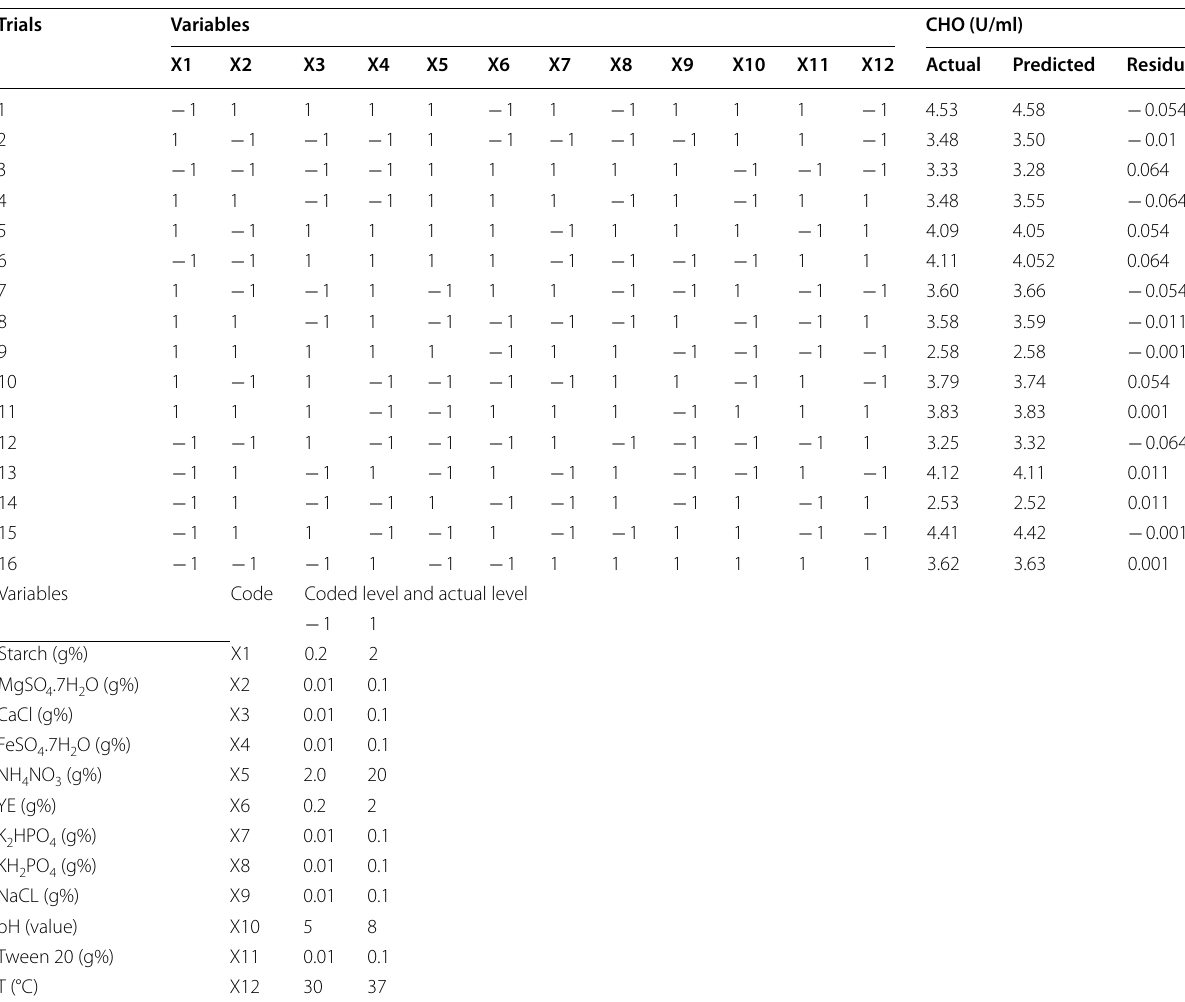
Table 1 Randomized PB matrix designed for evaluating the factors influencing the CHO production by Streptomyces sp. strain AN Trials